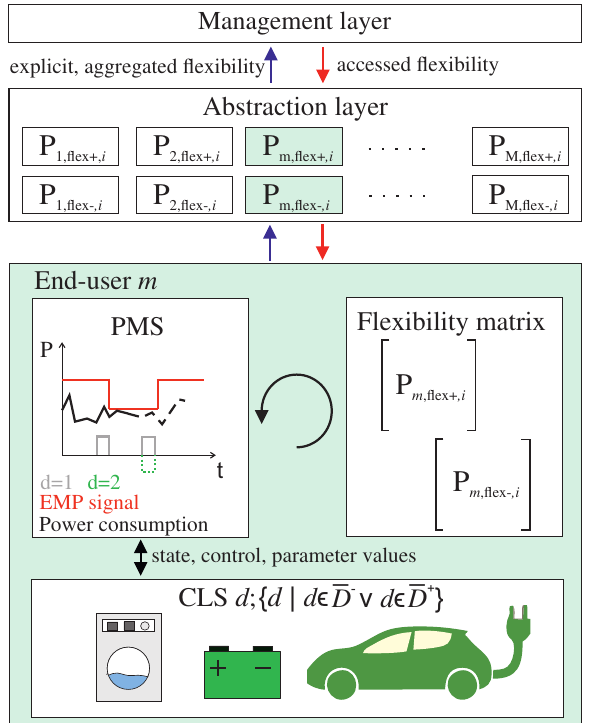
Figure 5. Information flow in the presented methodology from the controllable local system to management